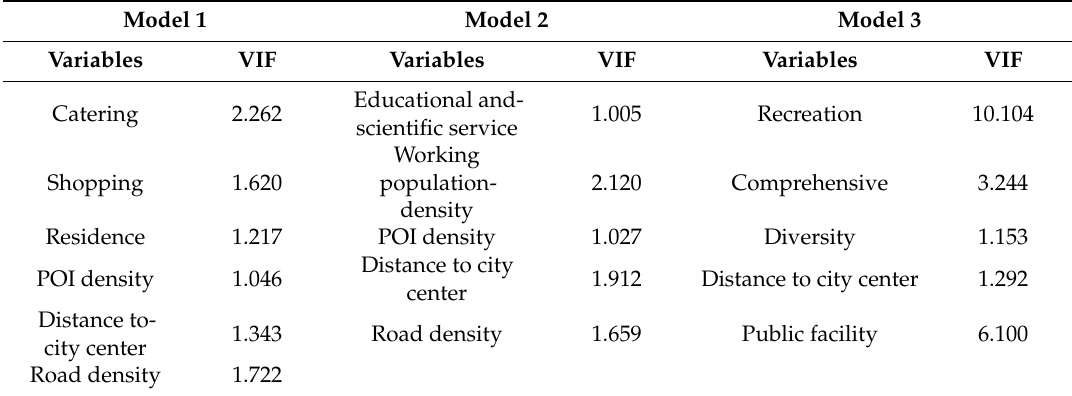
Table 5. Variance inflation factor (VIF) values of three regression